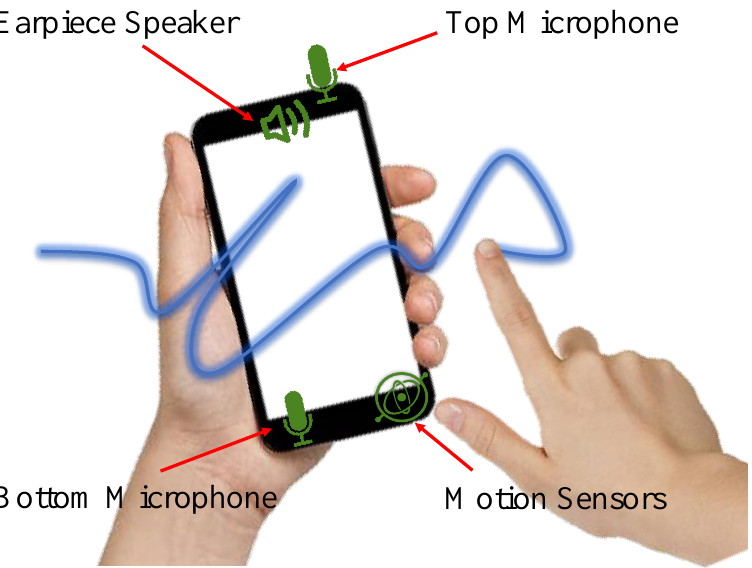
Figure 1. AirSign leverages both motion and acoustic sensors of smartphones to extract hand geometry, signature, and motion features while the user is signing his/her signature in the